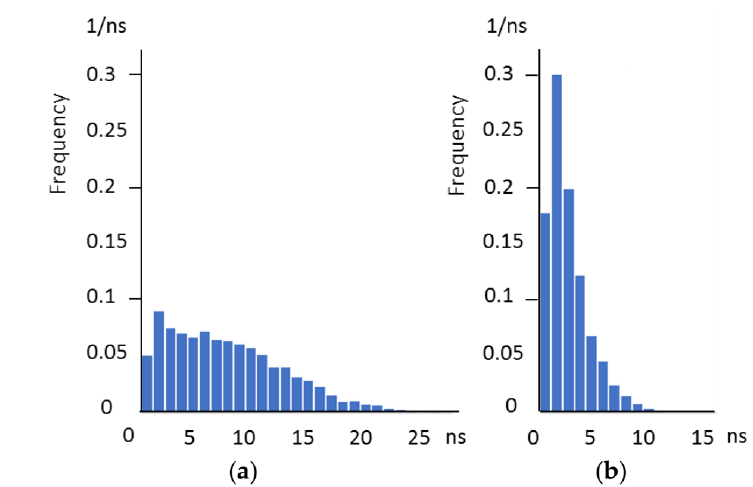
Figure 6. The arrival time distribution of signal electrons: ( a ) 100% fill factor and ( b ) 25% fill factor.